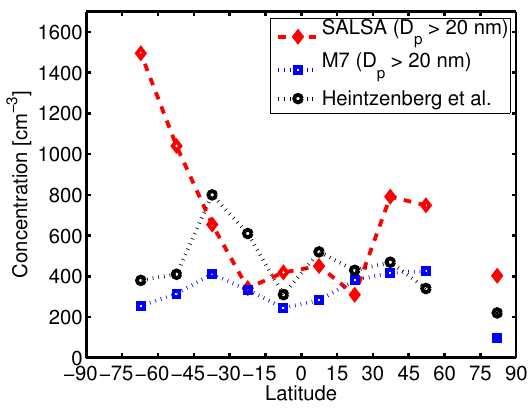
Fig. 7. Total annual mean sea surface concentration of particles in 10 latitude bands. Observed size distributions are marked with black, SALSA with red diamonds and M7 in blue squares. The observed mean values for the latitude bands are shown in black circles. As the observations have a lower cutoff diameter of 20 nm the modeled concentrations are shown only for particles larger than 20 nm in diameter.